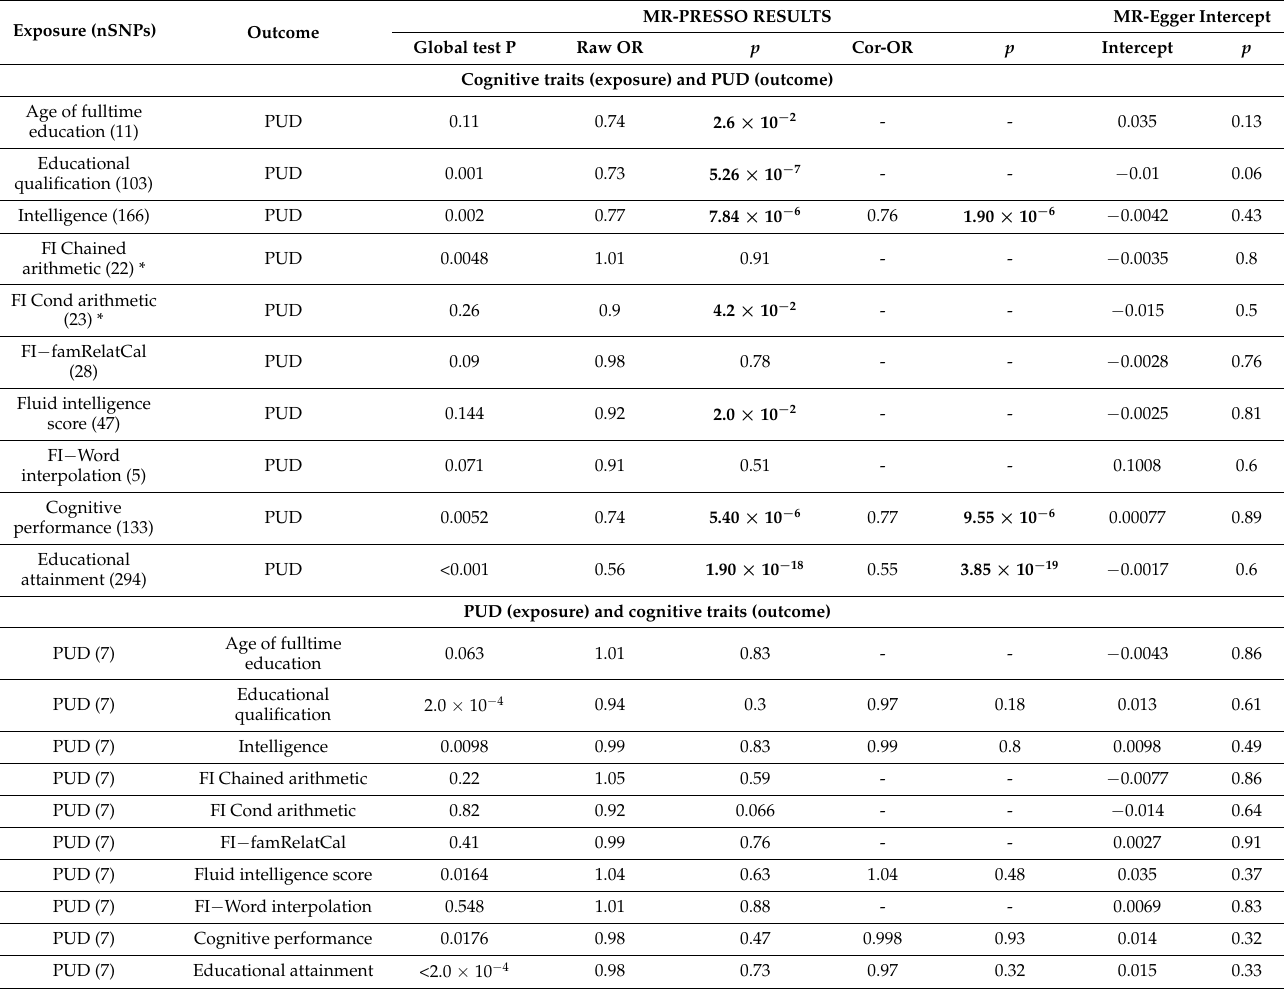
Table 4. Results of bidirectional MR-PRESSO analysis for PUD and cognitive